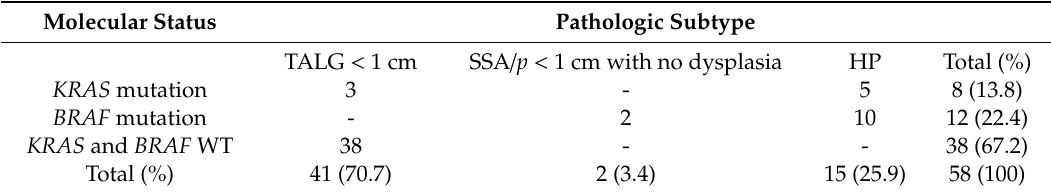
Table 3. Molecular status of non-advanced adenomas according to the pathological